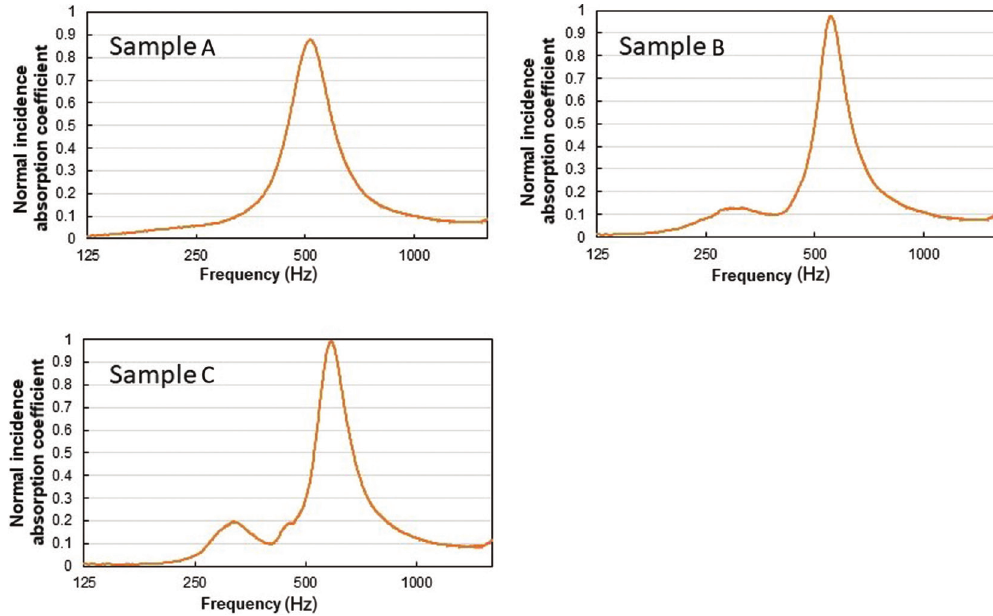
Results of the preliminary tests of Samples A, B and C using an impedance tube (transfer function method). Tests were performed with a square impedance tube of 100-mm length; therefore, the upper limit of the measurement frequency was 1600 Hz.